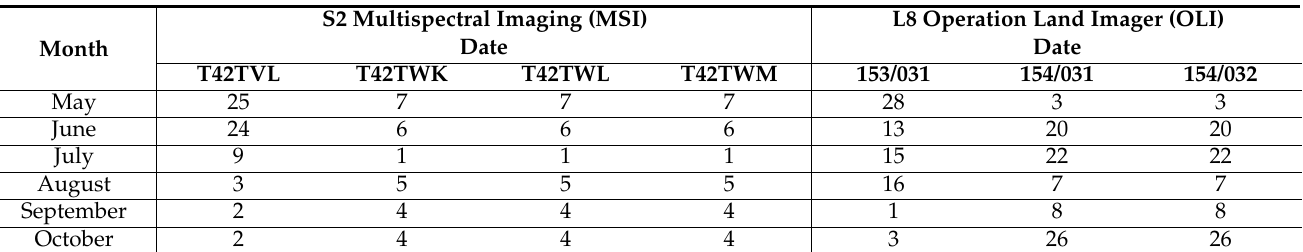
Table 1. S2 and L8 tiles were downloaded for the classification.